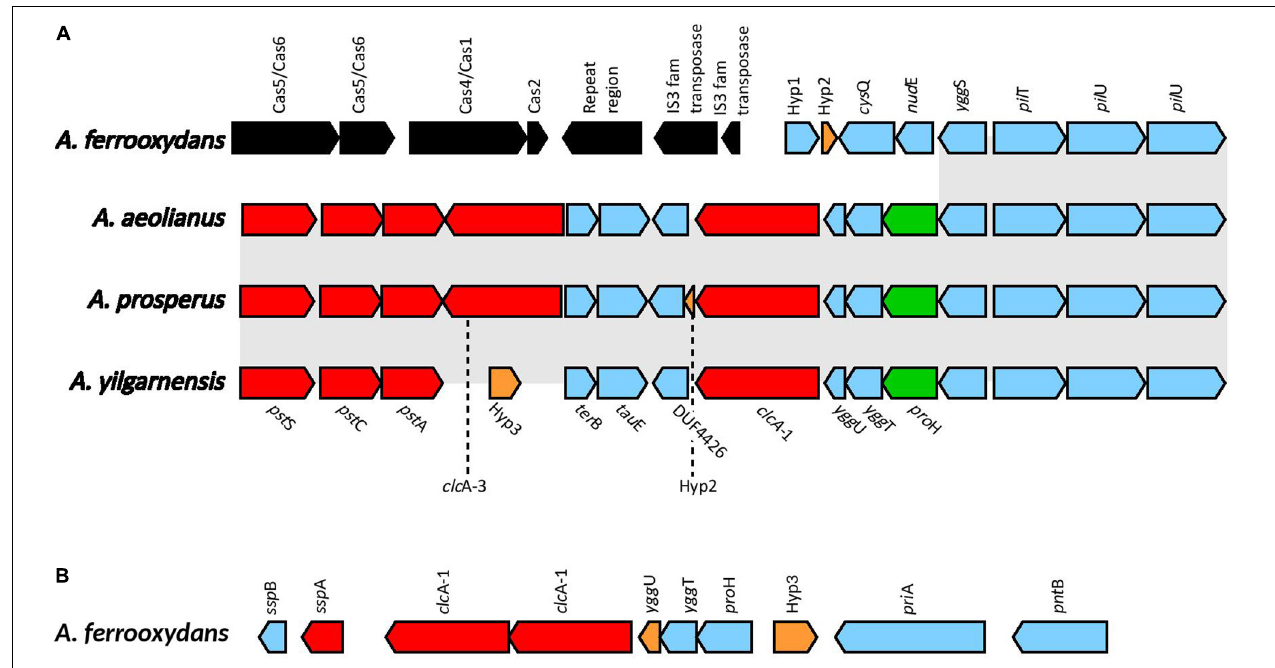
FIGURE 6 | (A) The genomic context of clc A-1 in A. yilgarnensis, A. prosperus and A. aeolianus . (B) The genomic context of the clcA-1 genes in A. ferrooxydans. Genes in red; involved in acid tolerance, in green; involved in osmotolerance, in blue; others, in black; genes associated with HGT. Hyp, hypothetical proteins with no predicted putative domains; cys Q, 3 (cid:48) (2’),5 (cid:48) -bisphosphate nucleotidase; nud E, ADP compounds hydrolase; ygg S, Pyridoxal phosphate homeostasis protein; pil T, type IV pilus twitching motility protein; pil U, type IV pilus ATPase; ter B, tellurite resistance protein; tau E, sulfite exporter; DUF4426, domain of unknown function 4426; ygg U, UPF0235 protein YggU; ygg T, uncharacterized protein; pro H, pyrroline-5-carboxylate reductase 1; ssp B, stringent starvation protein B; ssp A, stringent starvation protein A; pri A, primosomal protein N (cid:48) ; pnt B, NAD(P) transhydrogenase subunit beta.